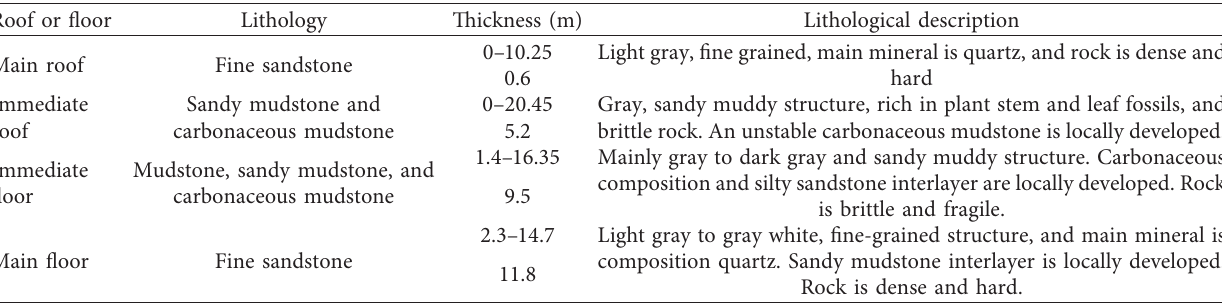
Table 1: The lithological distribution of the roof and floor of coal seam 11-2.